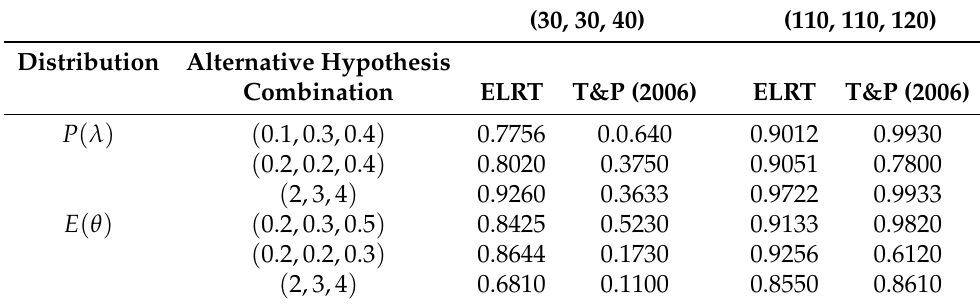
Table 4. Rejection rates ELRT and T&P (2006) under sample sizes ( 30,30,40 ) and ( 110,110,120 ) and different alternatives indicated in terms of